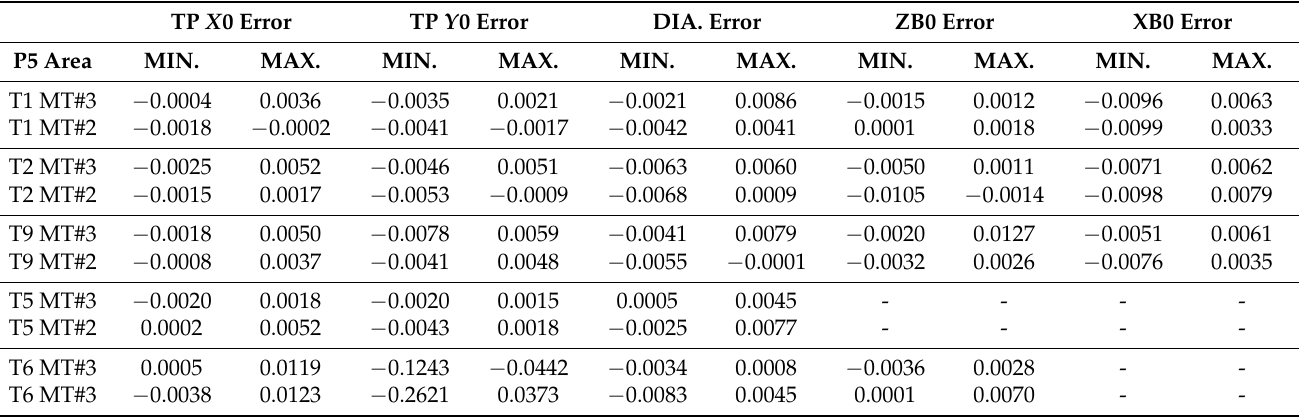
Table 7. Measurement dispersion for P5 area B 0 ◦ head positions for the probes T1, T2, T9, T5, and B 90 ◦ head position for T6. Results in [mm].